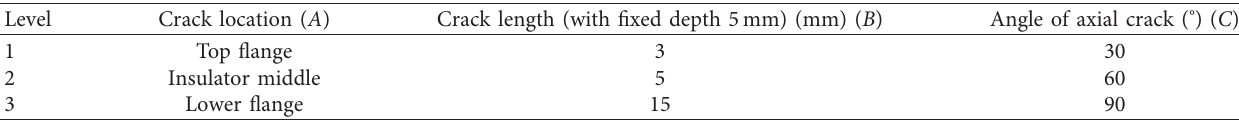
Table 6: Factor and level table of the